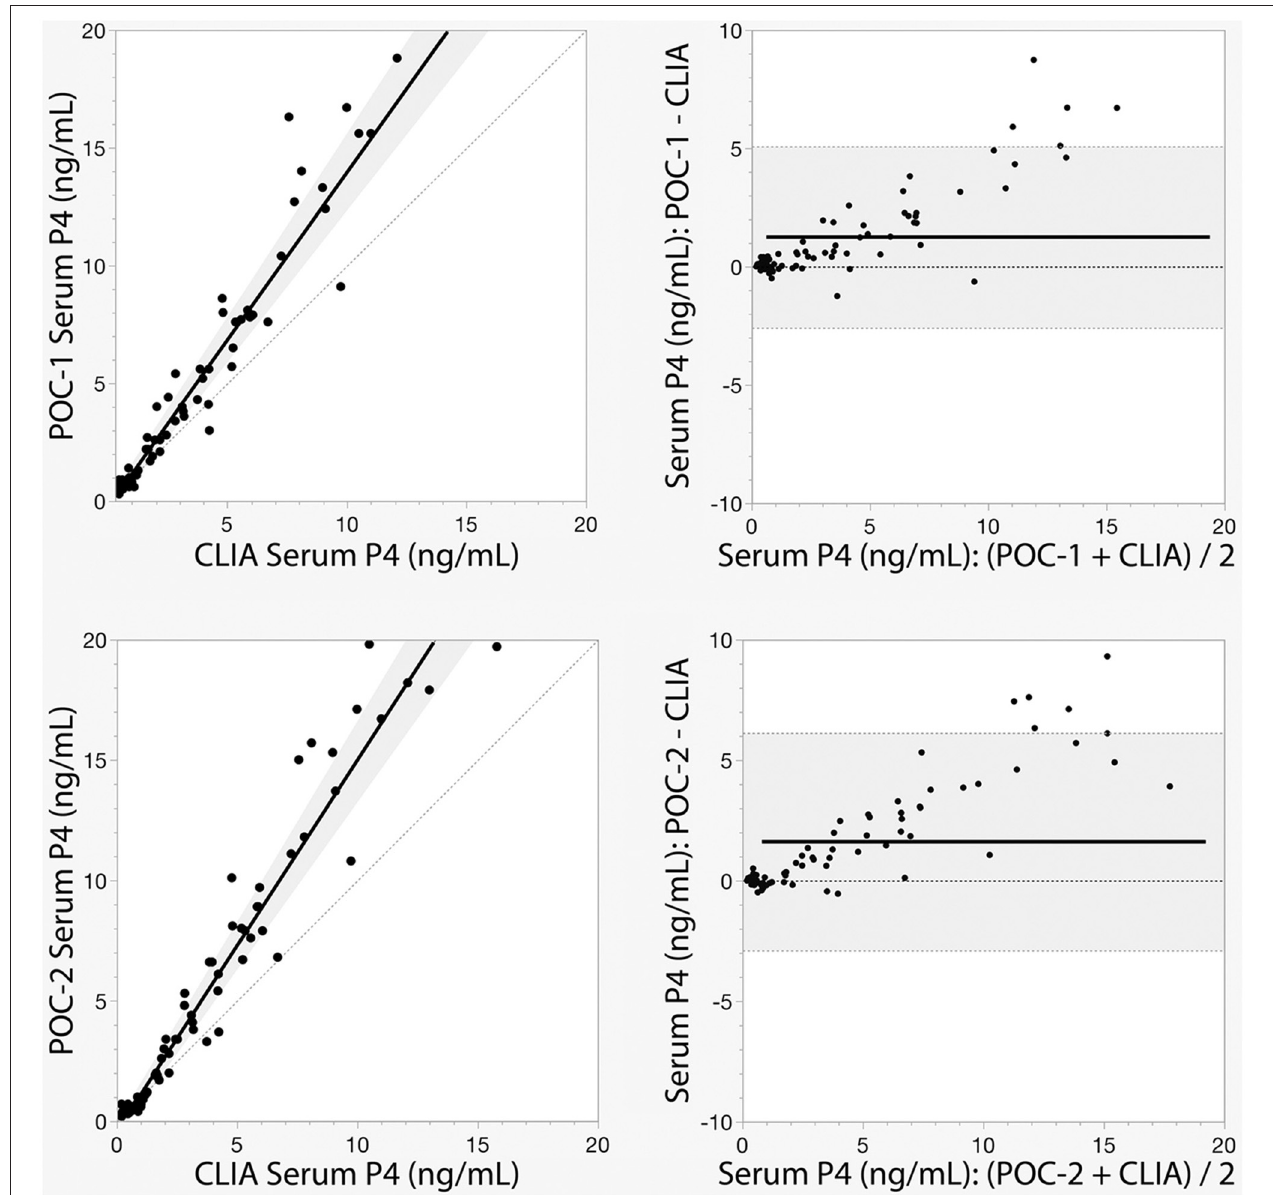
FIGURE 1 | Passing-Bablok regression (left) and Bland-Altman (right) graphs of canine serum progesterone (P4) concentrations measured by two point-of-care analyzers (POC-1 and POC-2) and a reference chemiluminescent immunoassay (CLIA). Passing-Bablok regression graphs show the black lines of best fit flanked by the shaded 95% confidence curves, and plotted with the gray line of identity (y = x). Bland-Altman bias graphs depict the black mean bias line with the shaded 95% limits of agreement lines; the gray line of no bias ( y = 0) is also